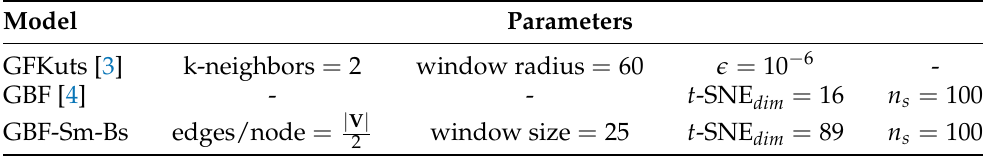
Table 1. Parameters used for the models GFKuts [3], GBF [4], and our proposal GBF-Sm-Bs model.